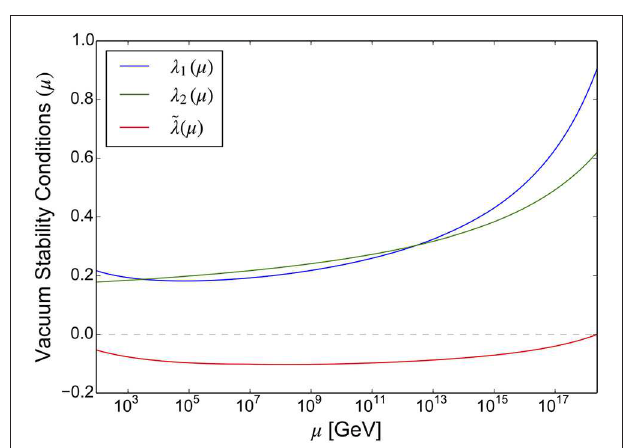
FIGURE 9 | Example running of λ 1 , λ 2 , and ˜ λ for a point that provides valid masses for the SM Higgs and the top quark in the Inert Doublet Model. Boundedness from below and vacuum stability requires that all three couplings are positive at all scales. This plot originally appeared in McDowall and Miller